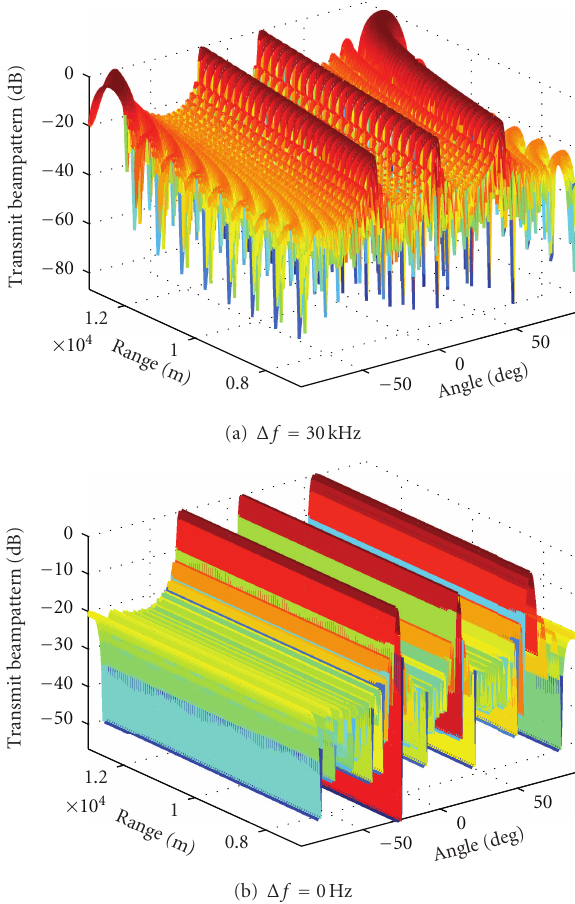
Figure 8: The comparative transmit beampattern when L = 1 . 5 λ